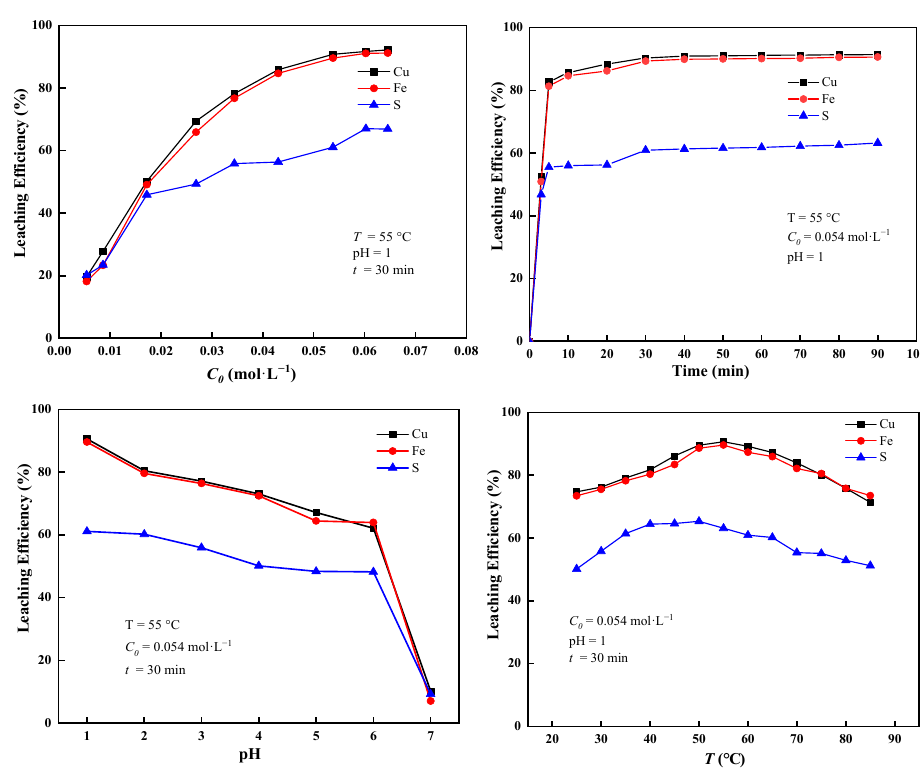
Figure 2. Extraction curves with TCCA.